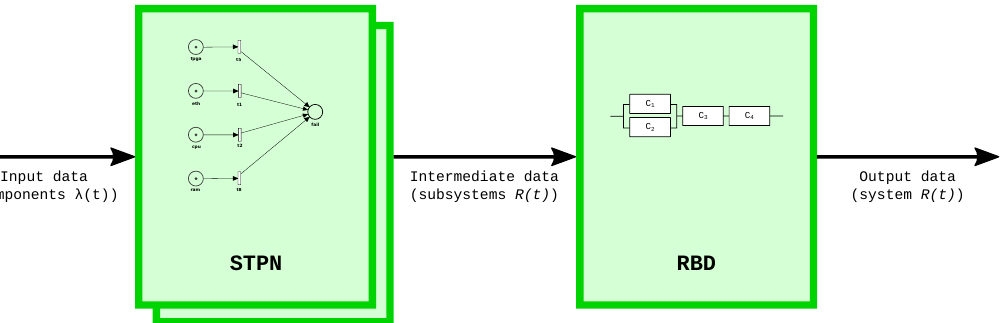
Figure 2. Application of layered reliability